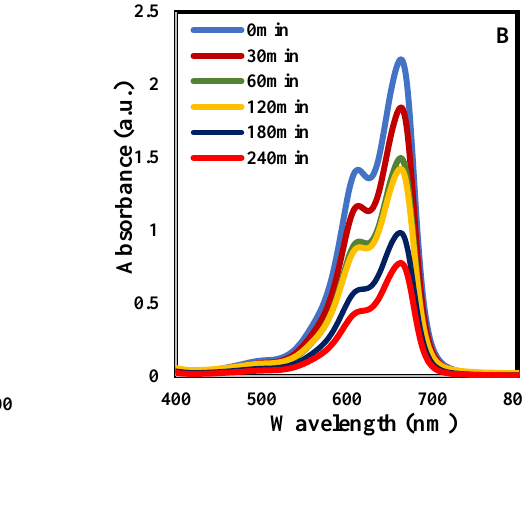
Figure 3: UV-Vis absorption spectra of photodegradation of MB dye (5ppm) by ZnO/ sawdust /epoxy nanocomposite with different ratios of ZnONPs (A) 0.1 (B) 0.3 (C) 0.5 (D) 0.7, and (E) 1 vol.%, respectively